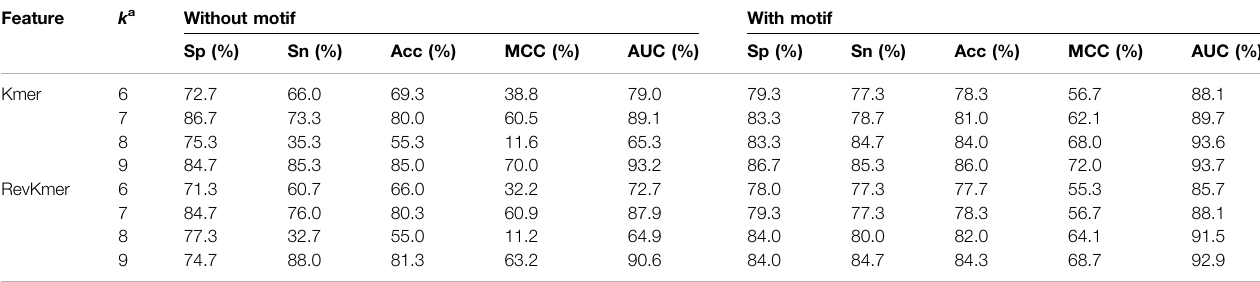
TABLE 3 | Data distribution of the training dataset and independent-testing dataset. Feature k a